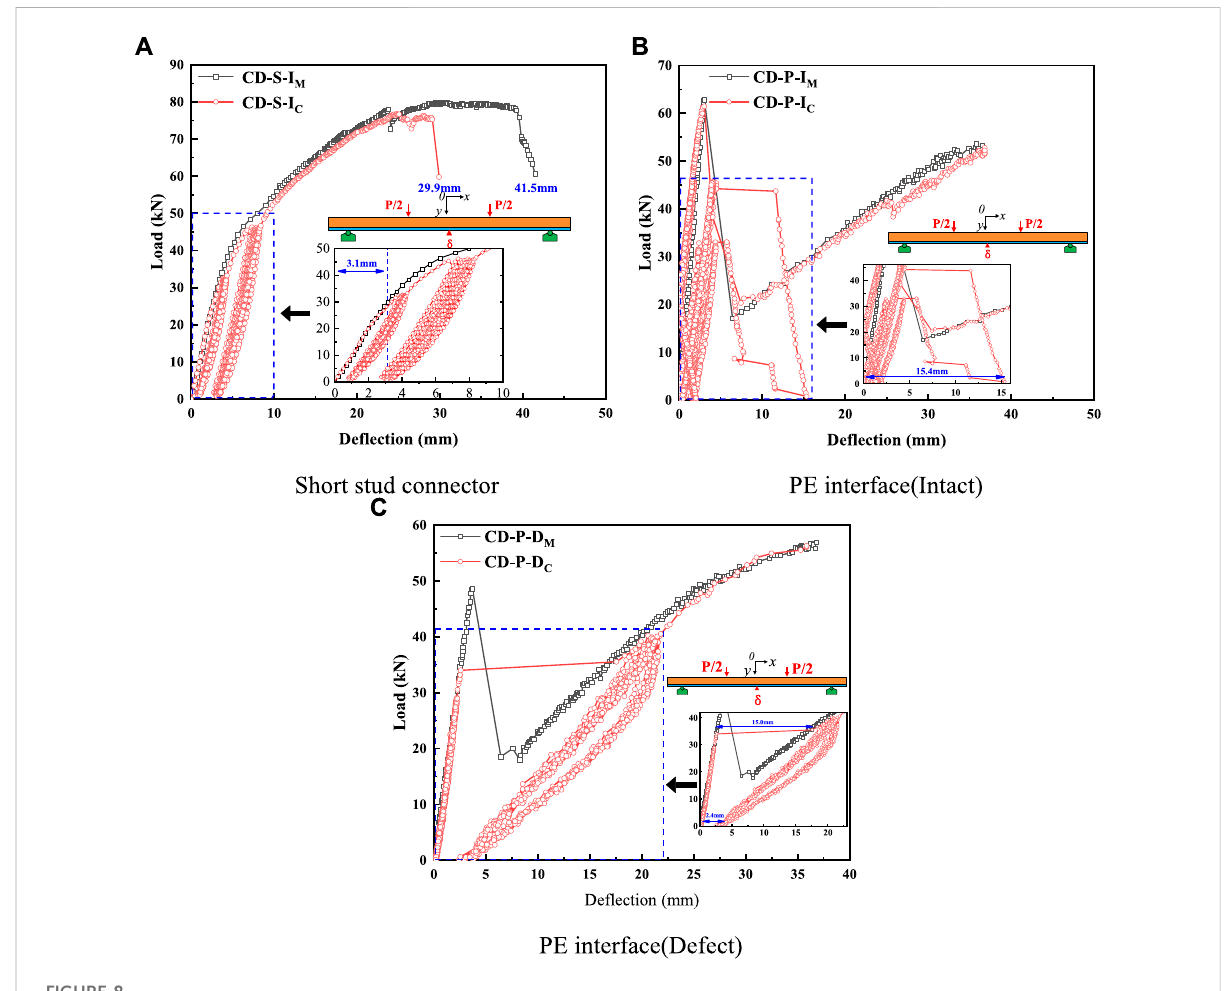
FIGURE 8 Load-de fl ection curve. (A) Short stud connector. (B) PE interface (Intact). (C) PE interface (Defact).